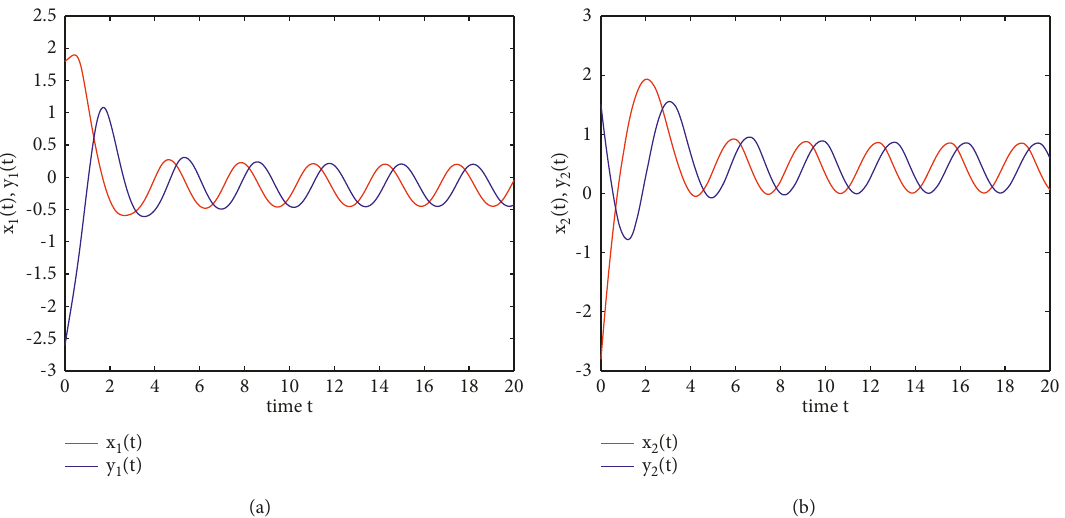
( t ) and y ( t ) for drive-response system without controller; (b) trajectories of x 1 1